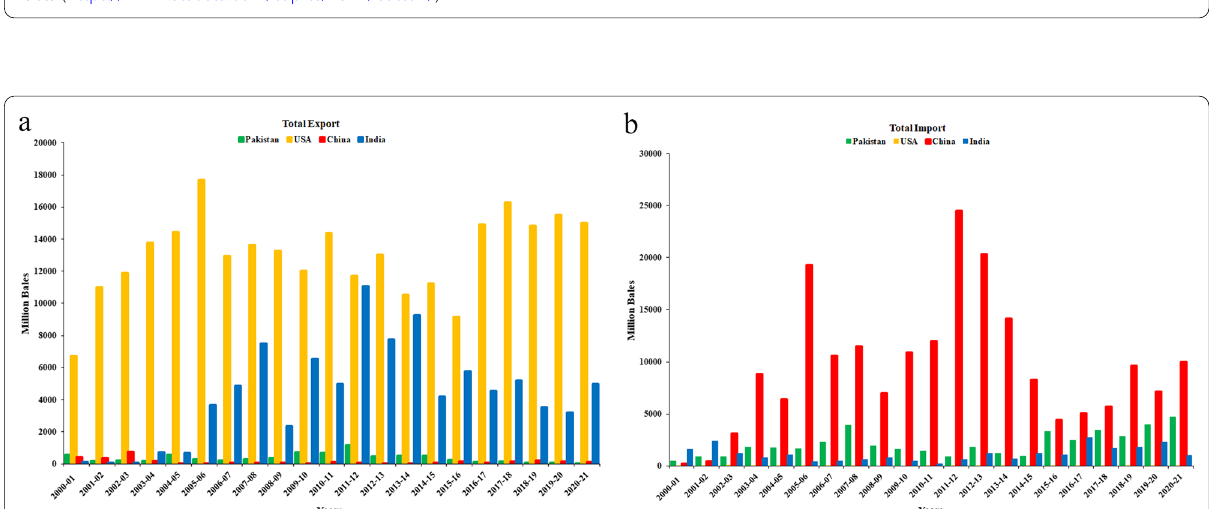
Fig. 2 Yield per hectare and total consumption of cotton in Pakistan, China, USA, and India during 2000–2021. Source of data Cotton-statistics & facts (https:// www. stati sta. com/ topics/ 1542/ cotton/)